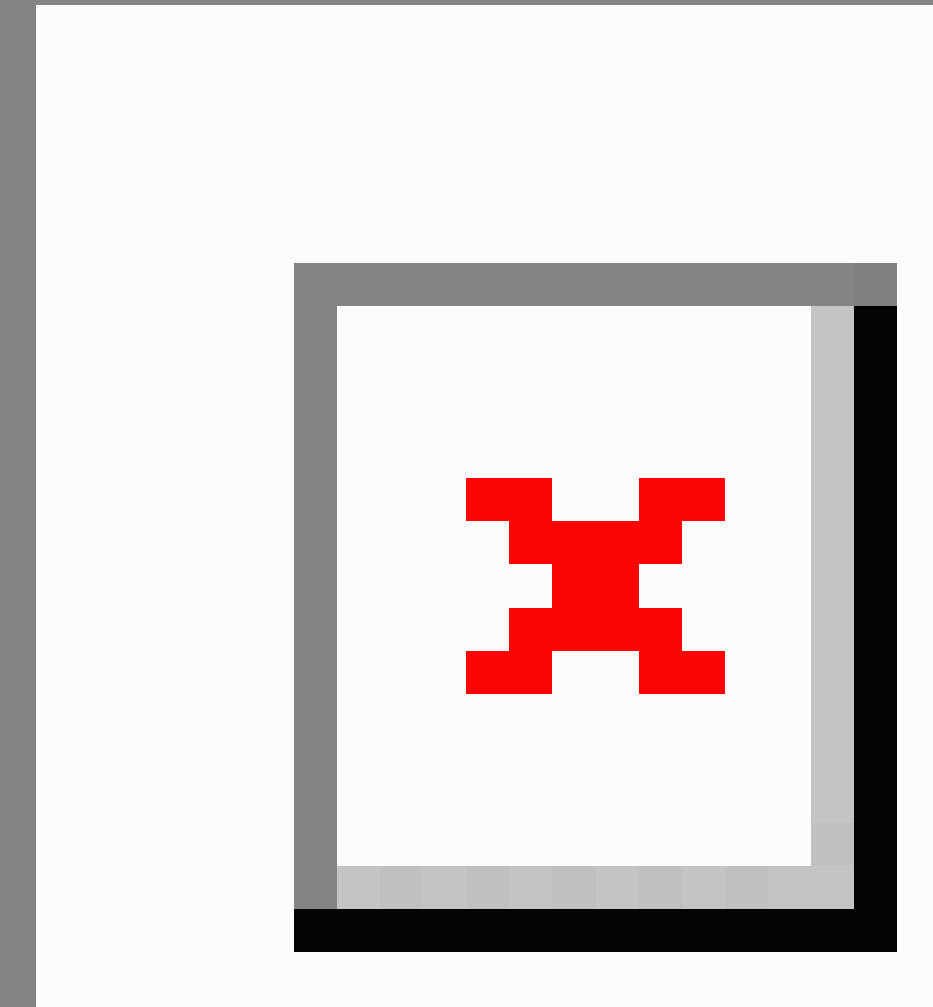
Figure 7. Snapshot of OnTrack